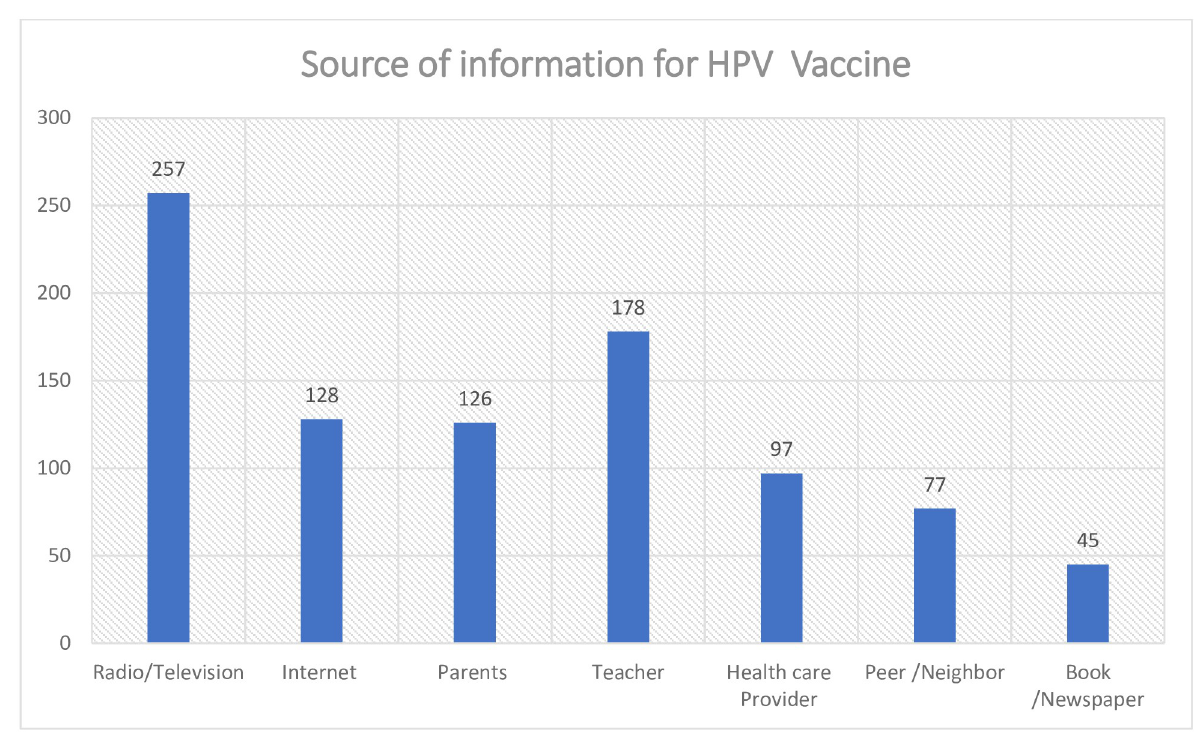
Fig 1. Source of information about HPV vaccine, Bahir Dar, Ethiopia,